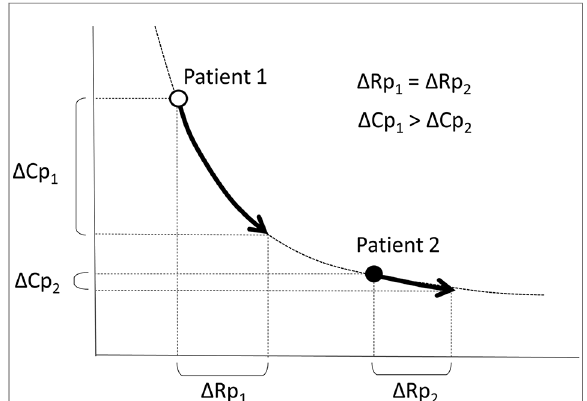
FIGURE 4 Unique relationship between Rp and Cp. A patient who is developing pulmonary hypertension is placed in the upper left region of the RC coupling curve (Patient 1, open circle) and moves from left to right along the curve. Then, a subtle increase in Rp is accompanied by a substantial decrease in Cp. Meanwhile, in a patent with more advanced stages of the disease (Patient 2, closed circle), Cp has already reached the minimum and any further increase in Rp